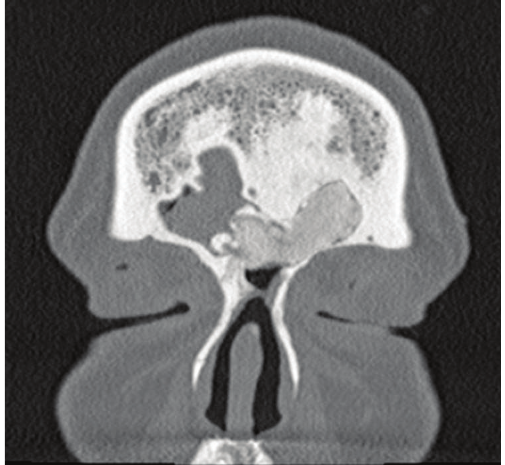
Figure 2: Coronal CT scan showing the osseous mass filling the left frontal sinus and extending into the right.